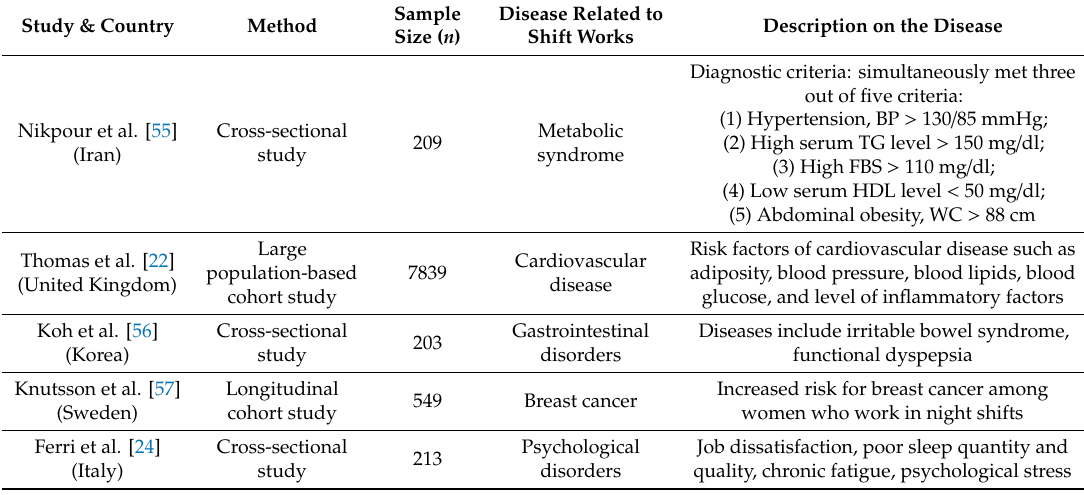
Table 1. Impact of shift work on health of